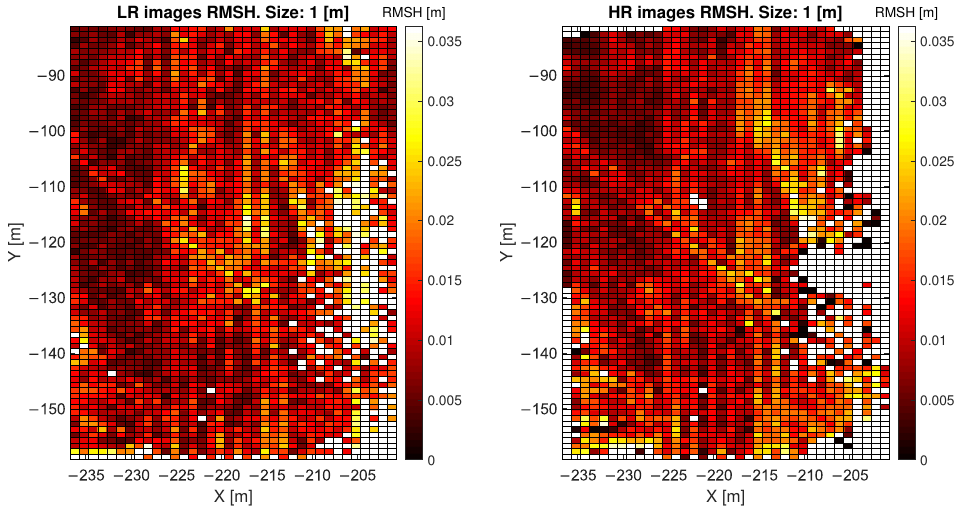
Figure 5. RMSH values evaluated for each pixel with 1m window size; comparison between HR and LR. The diagonal feature in the middle is a result of tire tracks from bulldozers crossing the study site. LR images RMSH. Size: 5 [m]